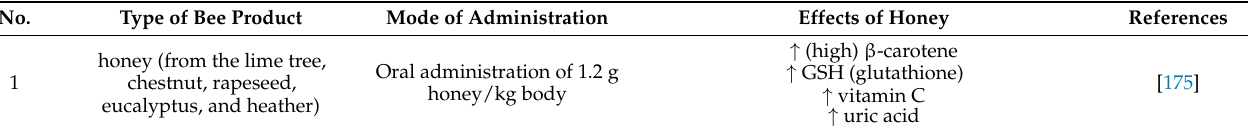
Table 3. Honey mechanism of